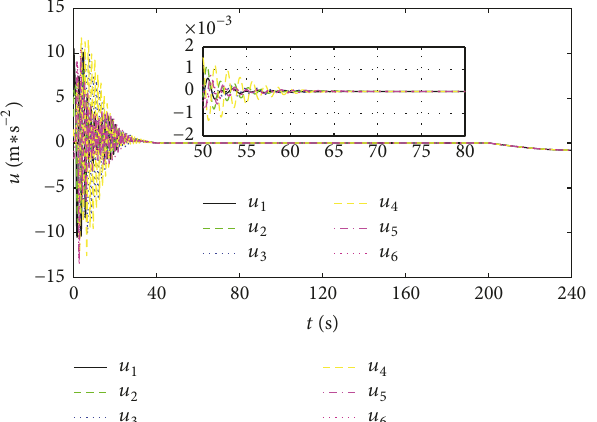
Figure 9: Performance comparison with absent velocity measure-